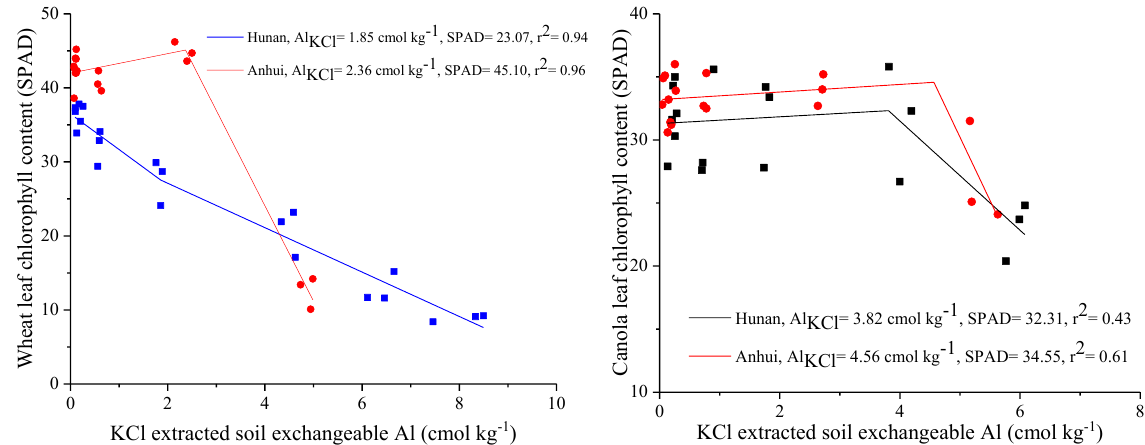
Figure 7. Leaf chlorophyll contents (SPAD value) of wheat and canola as a function of KCl extracted exchangeable Al of the Ultisols from Hunan and Anhui. The fitted equations were significant at P